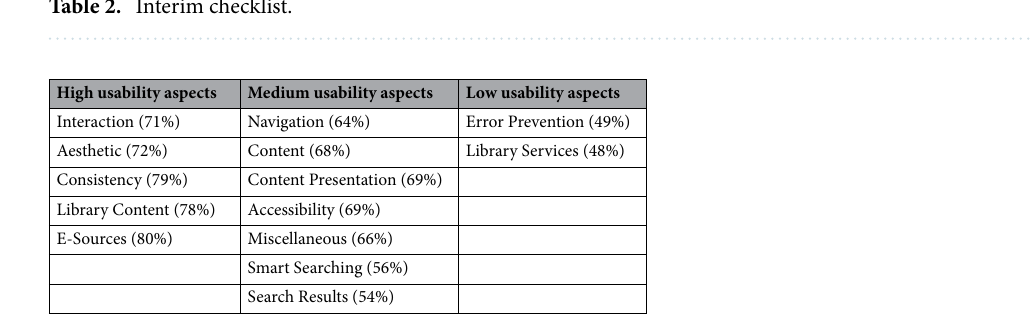
Table 3. Identified level of coverage of usability aspects: (the identified true usability aspects ranked as high (> = 70), Medium (> = 50) and Low (< 50)